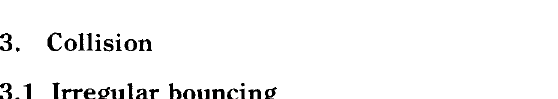
Fig. 1 Non-spherical particle ...... True sphere